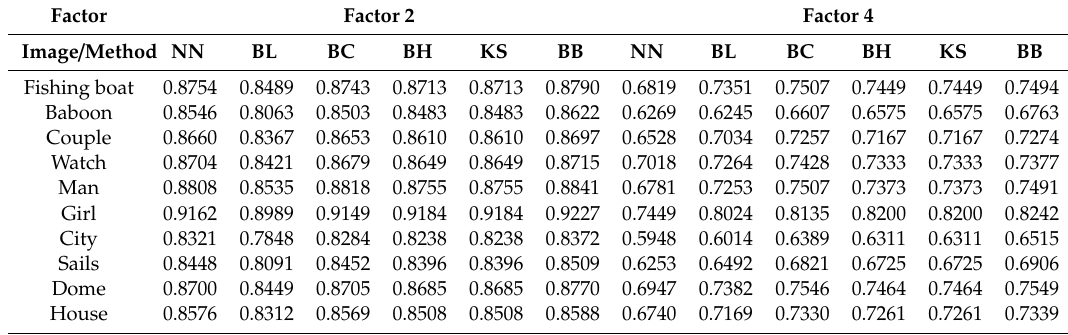
Table 10. Comparison results in terms of feature similarity (FSIM) index.